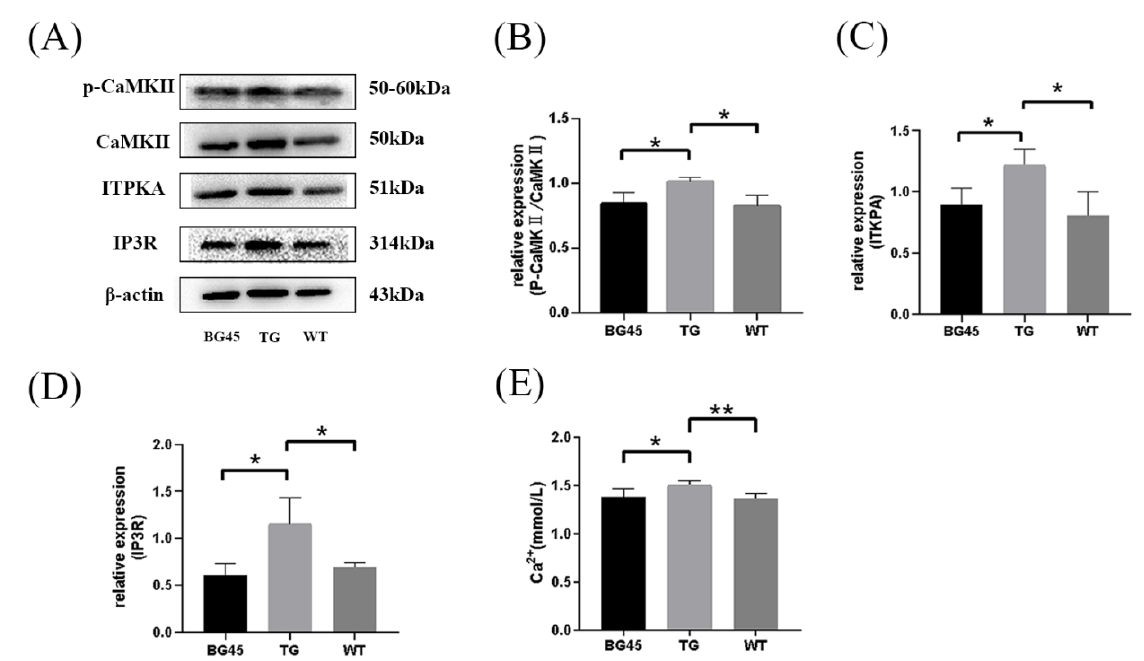
Figure 7. Effects of BG45 on p-CaMKII, CaMKII, ITPKA, IP3R and Ca 2+ . ( A ) Representative protein expression bands of p-CaMKII, CaMKII, ITPKA and IP3R. ( B ) Quantification of p-CaMKII/CaMKII analysis. ( C ) Quantification of ITPKA analysis. ( D ) Quantification of IP3R expression. ( E ) Impact of BG45 on serum calcium in APP/PS1 mice. The values are presented as the mean ± SD from three independent experiments. * p < 0.05, ** p < 0.01.